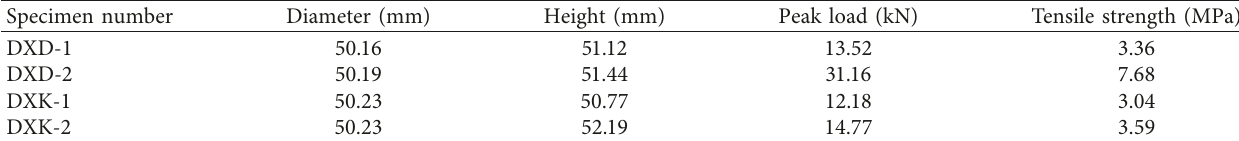
Table 3: Splitting tensile strength test results.